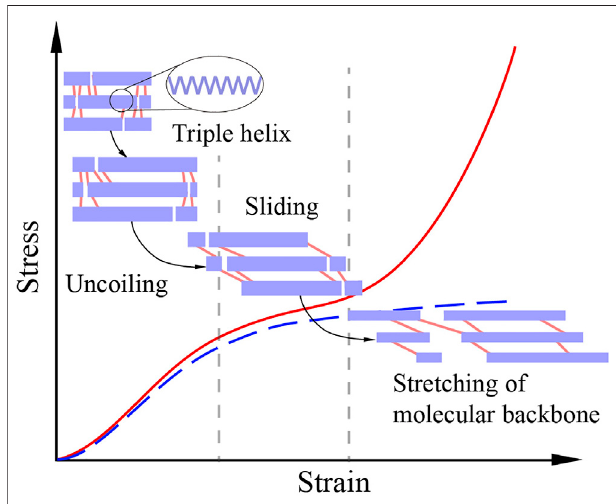
FIGURE 7 | The stress-strain response of a crosslinked collagen fi bril underunidirectionalstretching.Thepurplebarsrepresentcollagenmolecules, and the pink lines represent crosslinks. Collagen molecules fi rst uncoil their triple helix structures in the uncoiling stage. Then, a relatively gentle sliding stage is formed due to the sliding of molecules. Crosslinks also start to work in the sliding stage, restraining sliding and enhancing mechanical properties.Ifthestrength ofthecrosslinksisweakerthanthatofthemolecular backbones, the crosslinks will fail in the sliding stage, resulting in a two-stage response (the blue dot line). Otherwise, the molecular backbones will be stretched and generate a sharply rising curve segment, resulting in a three- stage response (the red line) (Svensson et al., 2013; Depalle et al., 2015).